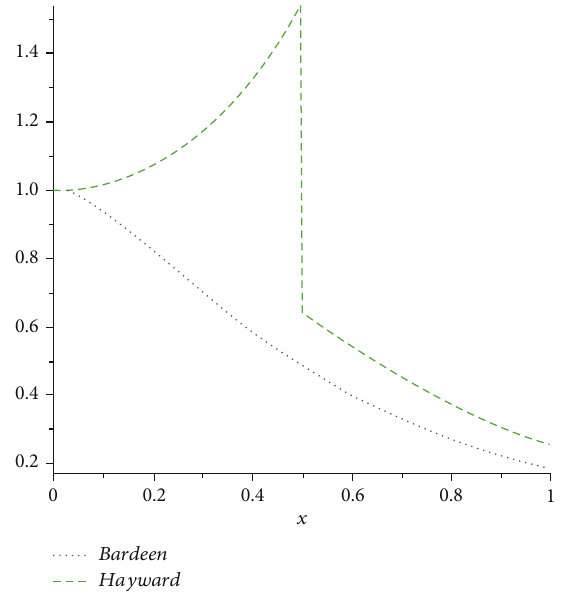
Figure 1: Gravitational entropy. The y axis is 90 S /3072 M and x = r 0 / R .